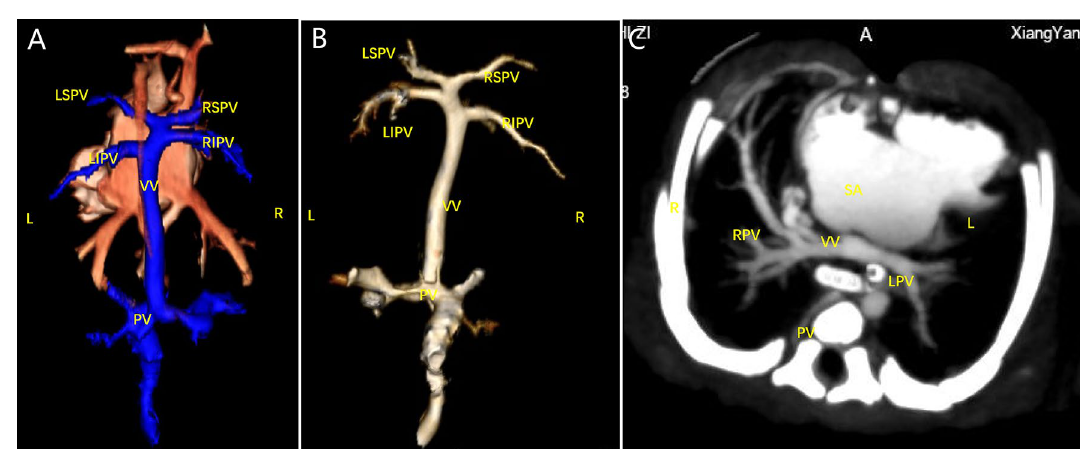
Figure 10. Postpartum CTA findings. ( A – C ) Left and right PVs converged to form a common PV trunk that flowed back to the portal vein via the vertical